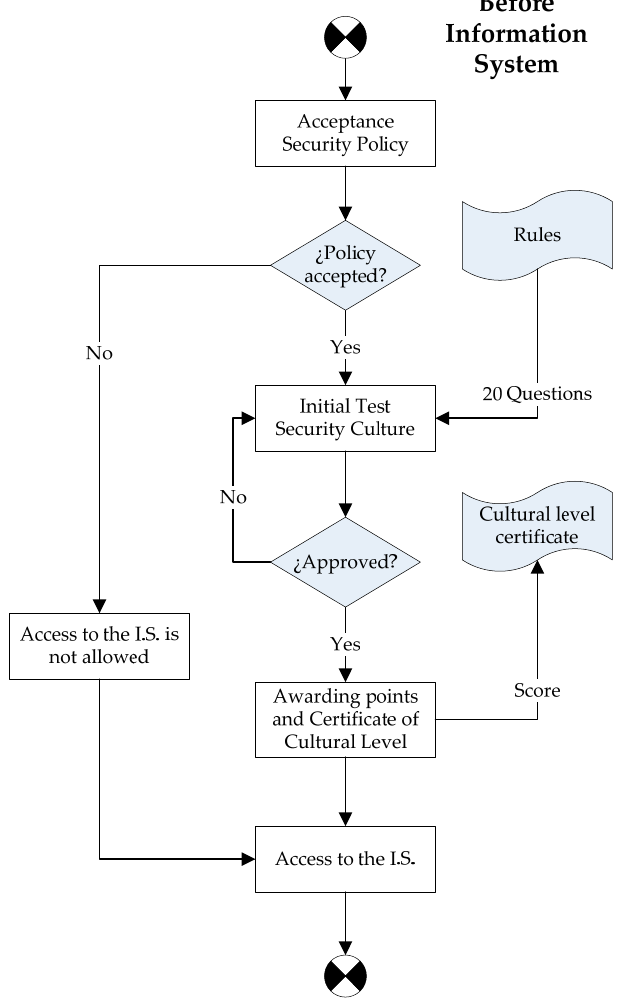
Figure 5. How a “security culture” certificate is initially obtained.